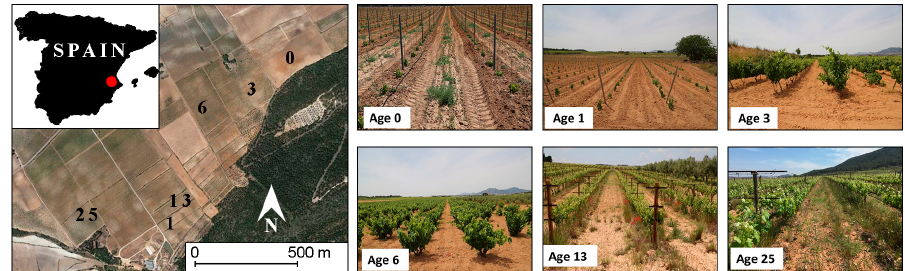
Figure 1. Areal view of the studied areas with investigated vineyard sites.